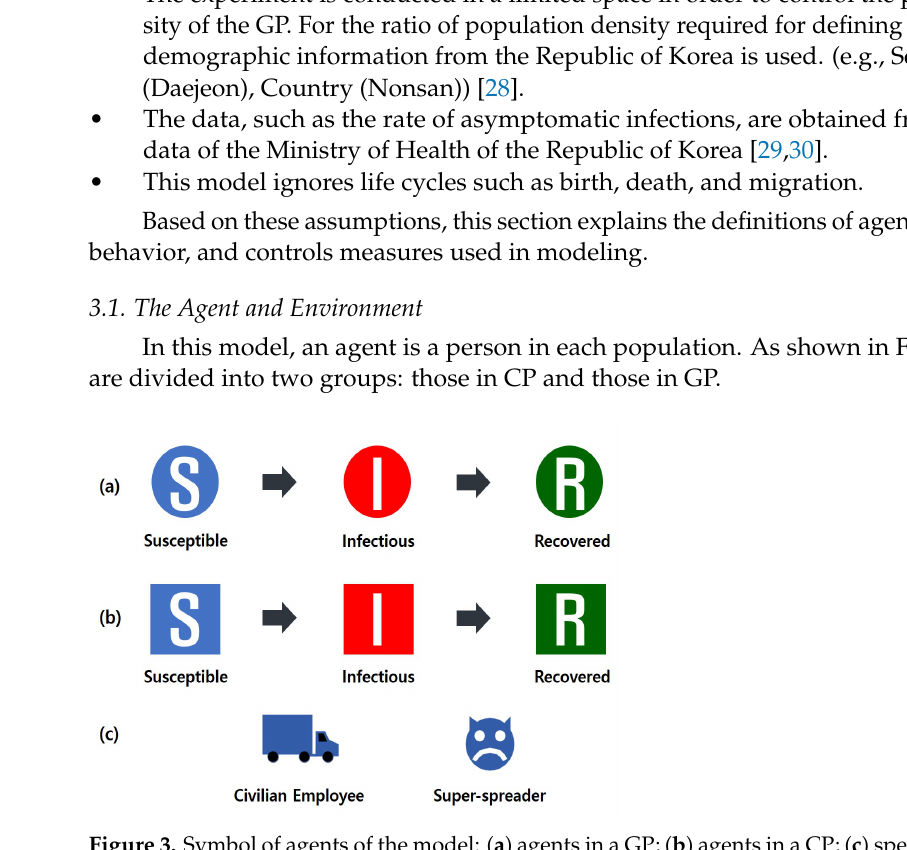
Figure 3. Symbol of agents of the model: ( a ) agents in a GP; ( b ) agents in a CP; ( c ) special agents (Civil- ian employee,